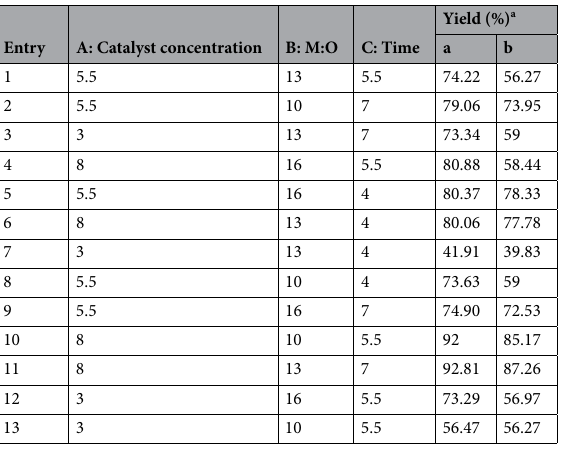
Table 2. Experimental data for the optimized yield of biodiesel from rapeseed oil (a) and waste corn oil (b) in presence of SSE@GO-CuFe